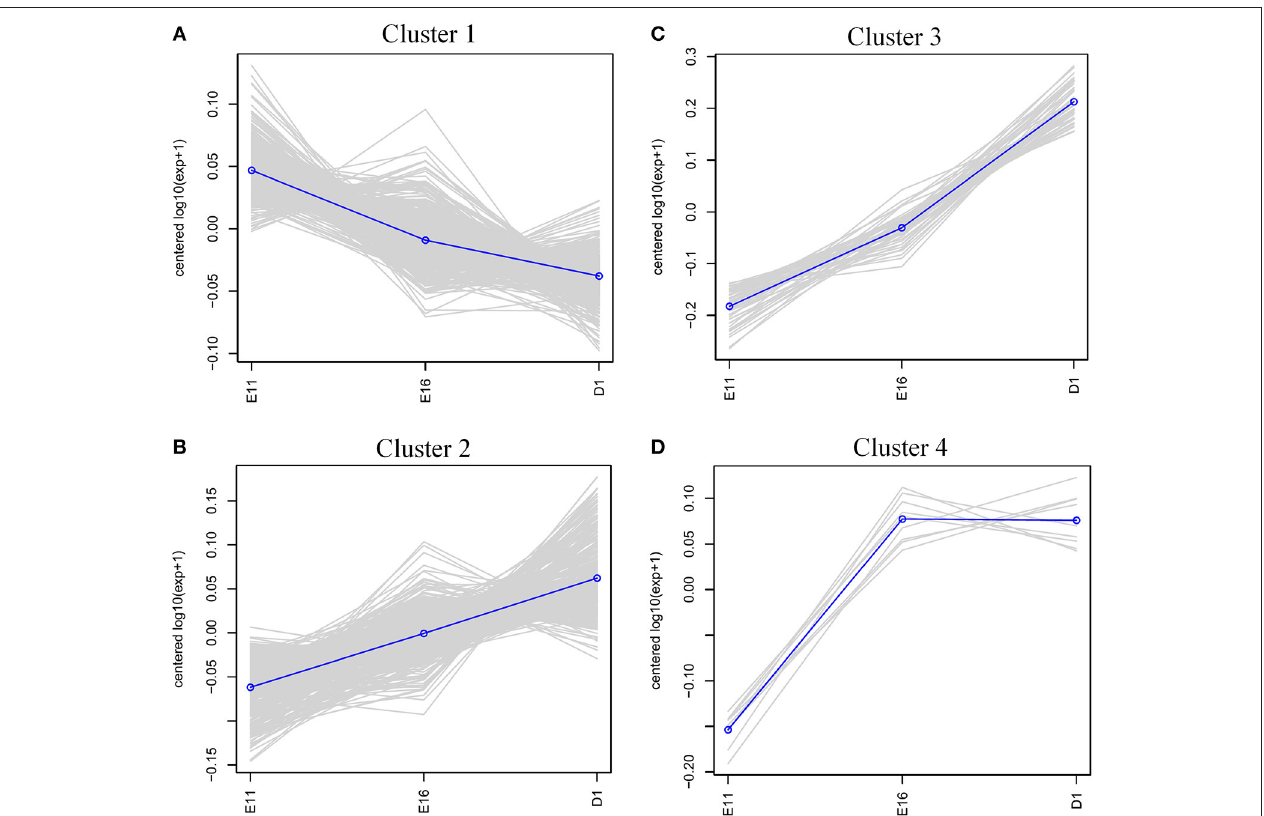
FIGURE 3 | Clustering analysis of the expression patterns of differentially expressed proteins. (A) Cluster 1 (476 proteins); down-regulated consistently from E11 to D1. (B) Cluster 2 (358 proteins); up-regulated steadily from E11 to D1. (C) Cluster 3 (52 proteins); up-regulated sharply from E11 to D1. (D) Cluster 4 (9 proteins); up-regulated sharply from E11 to E16, but then no significant change at D1.